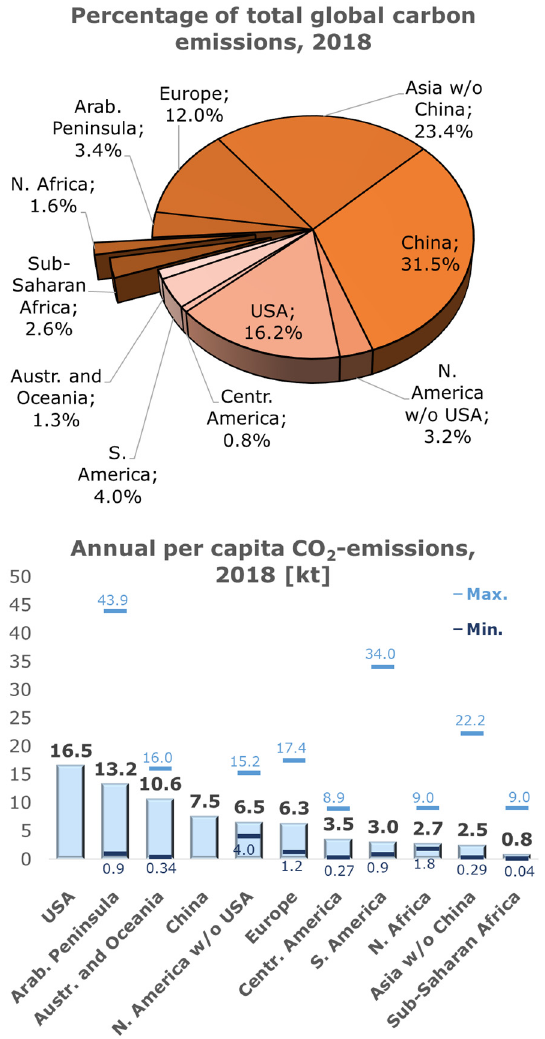
Figure 1. Percentage contribution of different regions to the global carbon emissions (a) and per capita carbon emissions for the respective regions (b) (data source